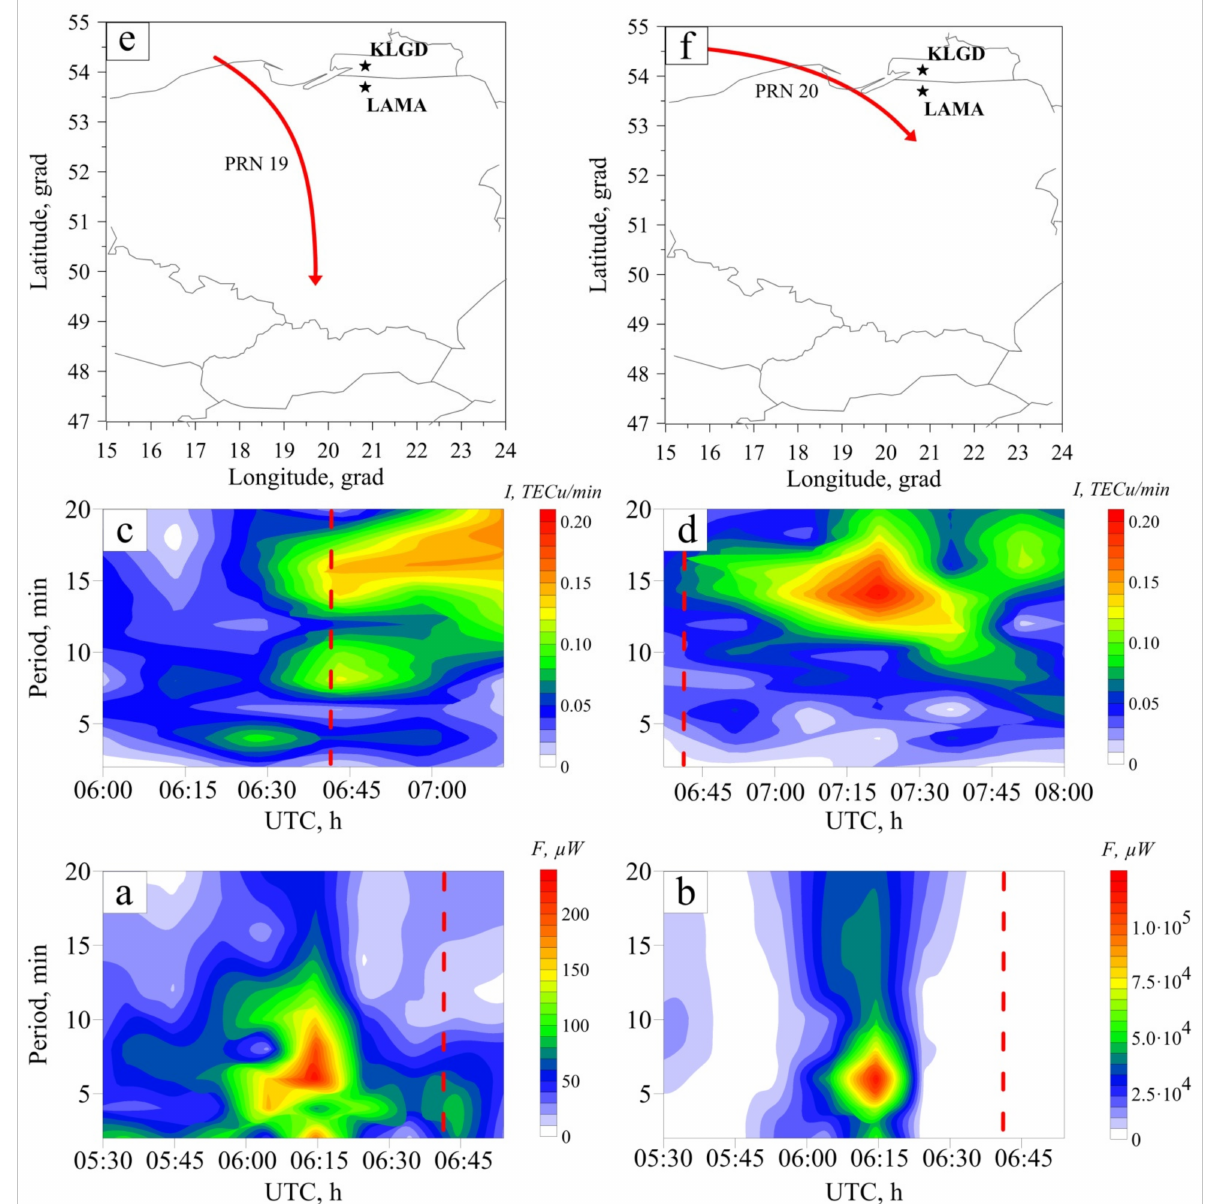
Figure 3. Spectra of variations of the troposphere (bottom row) and ionosphere (middle row) parameters during the passage of the morning solar terminator on 19 March 2012. Lidar measurements were carried out by the KLGD station at wavelengths: ( a ) λ 1 = 1064 nm; ( b ) λ 2 = 532 nm. Propagation beam length is L m = 4000 m. Satellite GPS measurements were performed at the mid-latitude station LAMA: ( c ) PRN 19; ( d ) PRN 20. Projections of satellite trajectories corresponding to the time scale of satellite measurements are: ( e ) PRN 19; ( f ) PRN 20. The arrows indicate the direction of satellite movement. The terminator transit time corresponds to 6:43 UTC and is indicated by the red dotted